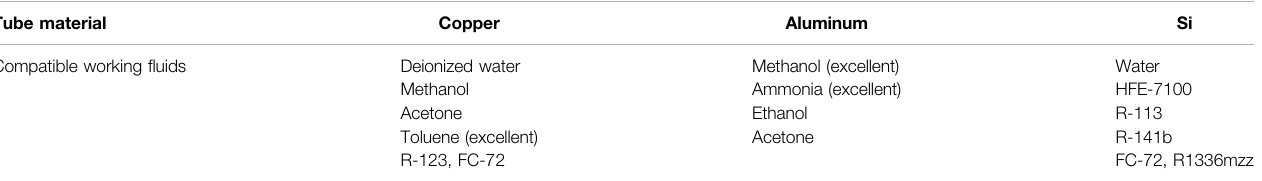
TABLE 1 | Working fl uid compatible with copper/aluminum/Si PHPs for electronics cooling.